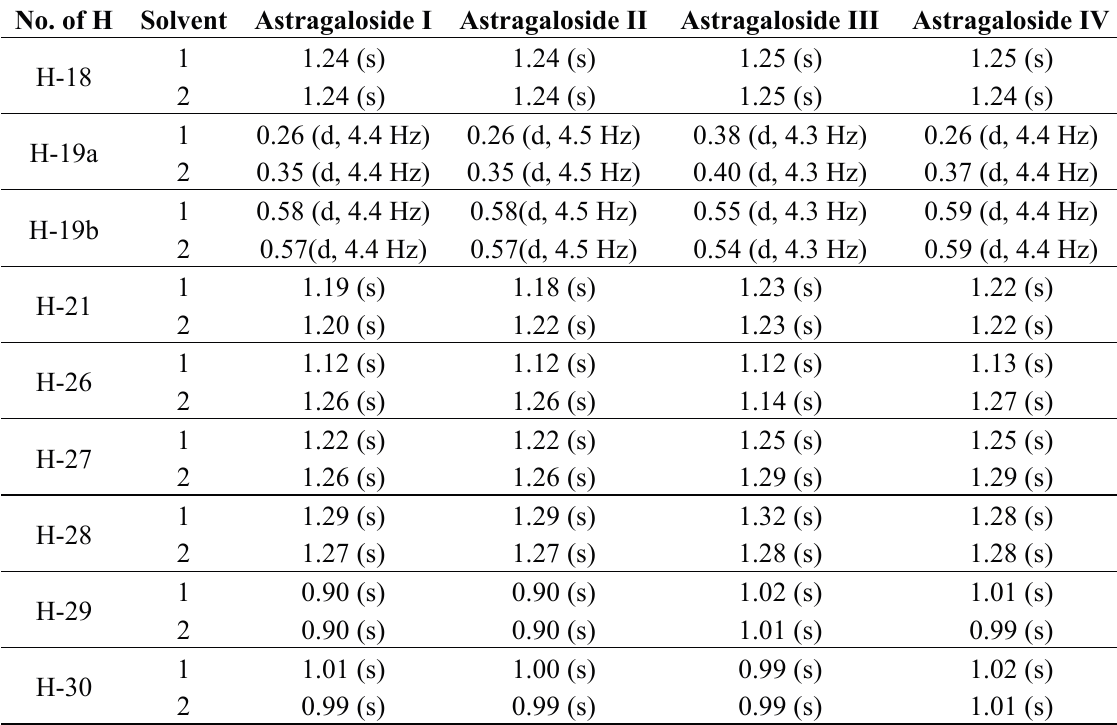
Table 1. 1 H-NMR chemical shifts (ppm) and coupling constants (Hz) of methyls and H-19 of astragaloside I, II, III, and IV in CD 3 OD a (Solvent 1) and CD 3 OD-KH 2 PO 4 buffer in D 2 O (1:1, v/v) b (Solvent